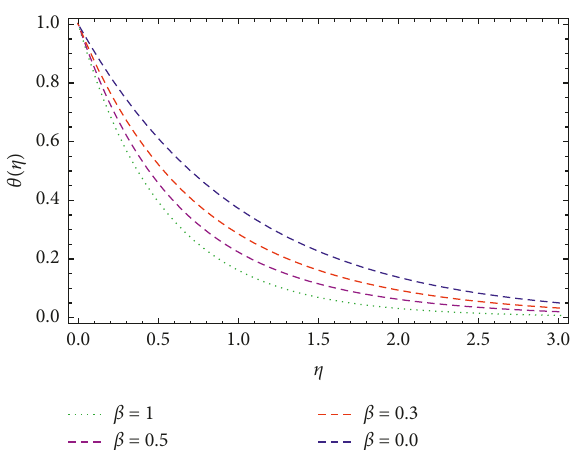
Figure 5: The influence of the temperature profile for different values of β , when K � 0 . 1 , f w � 0 . 3 , λ � 0 . 2 , Pr � 5 . 0 ,E c � 0 . 4 , and a ∗ � b ∗ � 0 . 2 .